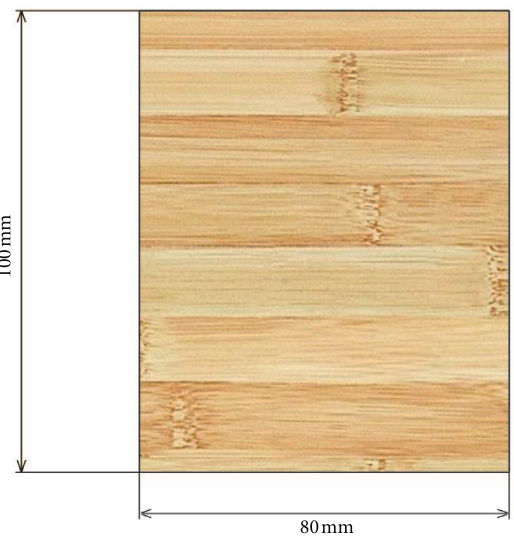
Figure 5: Cross-sectional area. Table 1: Basic information of Group